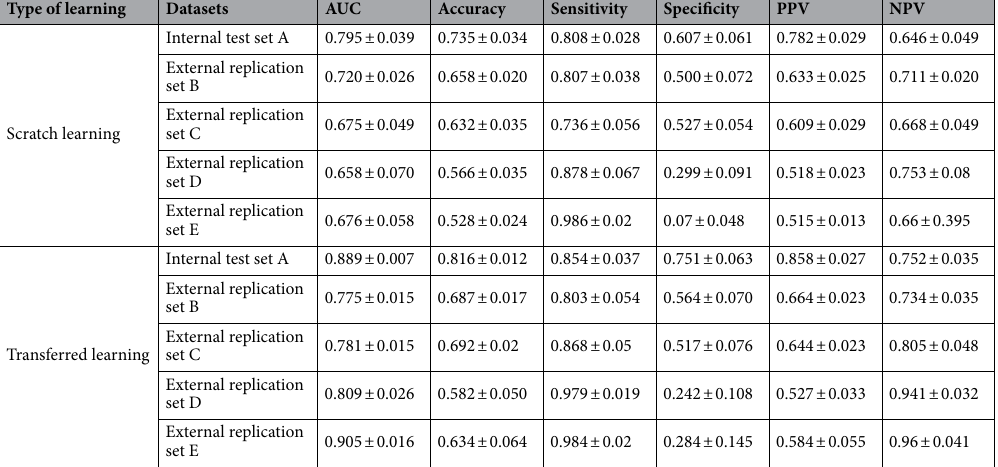
Table 1. Comparison of the performance between scratch and transferred learning models.